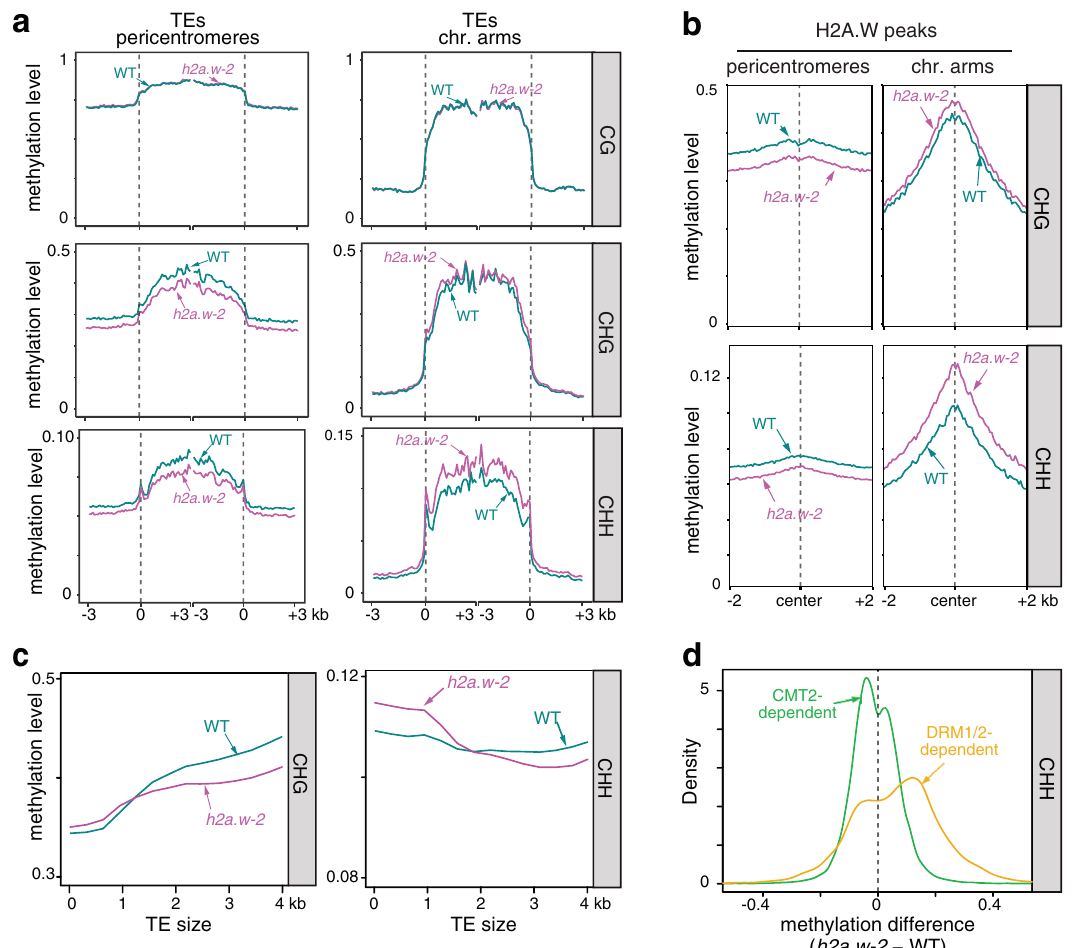
Fig. 2 Loss of H2A.W alters non-CG DNA methylation patterns. a CG, CHG, and CHH methylation levels over TEs in pericentromeres and chromosome arms in WT and h2a.w-2 . TEs were aligned at the 5 ′ (left dashed line) and 3 ′ end (right dashed line), and sequences 3 kb upstream or downstream were included, respectively. Average methylation over 100 bp bins is plotted. b CHG and CHH methylation levels over H2A.W peaks in the chromosome arms and pericentromeres. c Locally weighted scatterplot smoothing (LOESS) fi t of CHG and CHH methylation levels in WT and h2a.w-2 calculated in 50 bp windows and plotted against TE size. d Kernel density plots of CHH DNA methylation differences between h2a.w-2 and WT at CMT2-dependent and DRM1/2-dependent